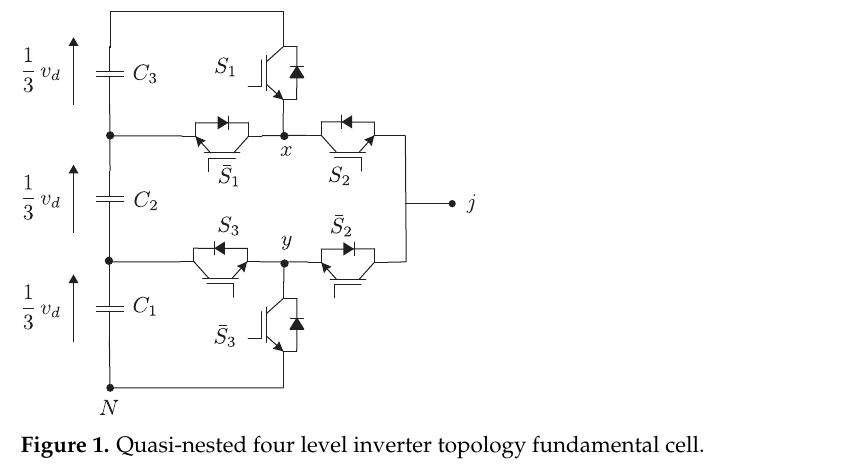
Figure 1. Quasi-nested four level inverter topology fundamental cell.